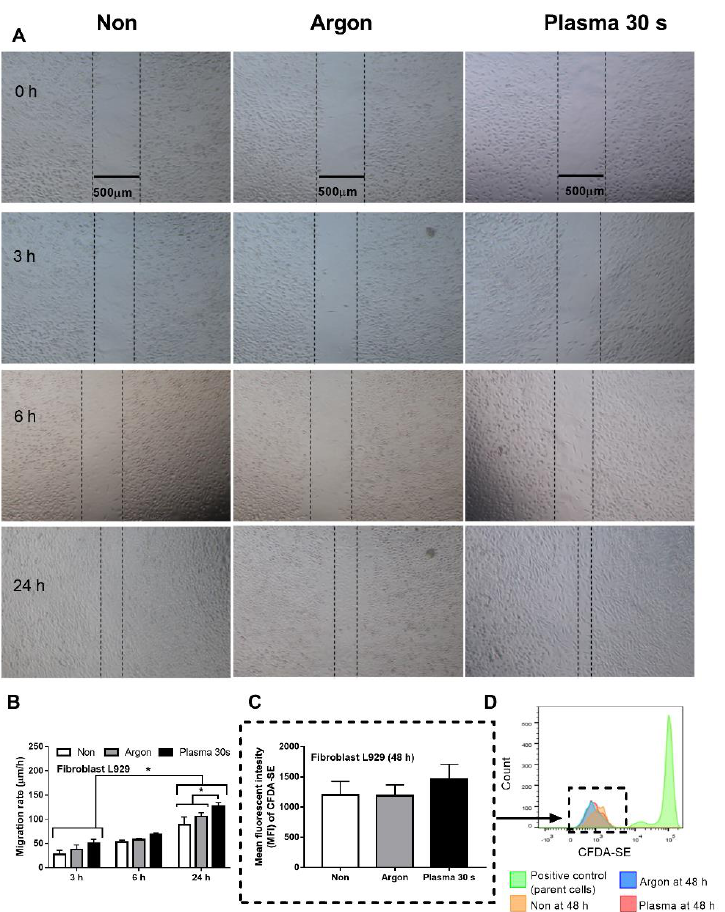
Figure 4. Responses of fibroblasts (L929 cell line) to plasma treatment (30 s), when compared with cells without stimulation (Non) or stimulated with argon gas alone (Argon) as evaluated by fibroblast migration (fibroblast scratch assay) with the representative microscopic photographs at different time points and scoring comparison ( A , B ) with fibroblast proliferation, using carboxyfluorescein diacetate succinimidyl ester (CFDA-SE) fluorescent staining and the representative flow cytometry analysis for CFDA-SE ( C , D ) are demonstrated. Independently triplicated experiments were performed.